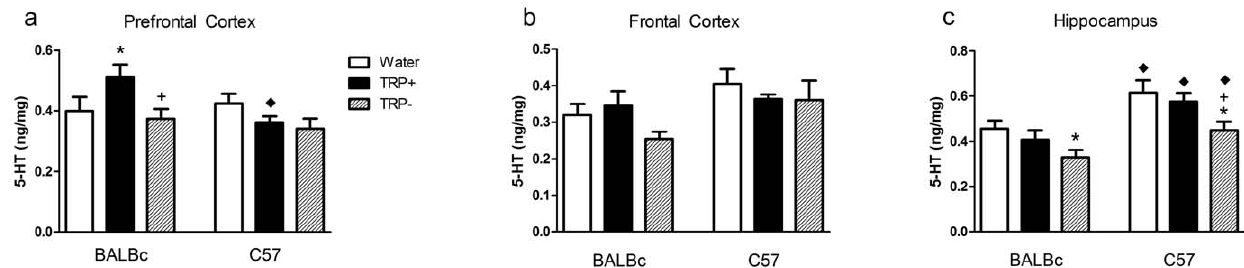
Figure 4. Brain 5-HT. Brain 5-HT content in ng/mg tissue in (a) prefrontal cortex (b) frontal cortex and (c) hippocampus. Animals were treated as described in Figure 2. Only vehicle treated animals are shown. N=5–6/group. * different from Water, + different from TRP + , ¤ different from corresponding group in BALBc mice. 5-HT content was lower at baseline in BALBc in the hippocampus; TRP 2 significantly decreased 5-HT content in the hippocampus; TRP + did not consistently increase 5-HT content; TRP 2 was consistently lower than TRP + in all regions.